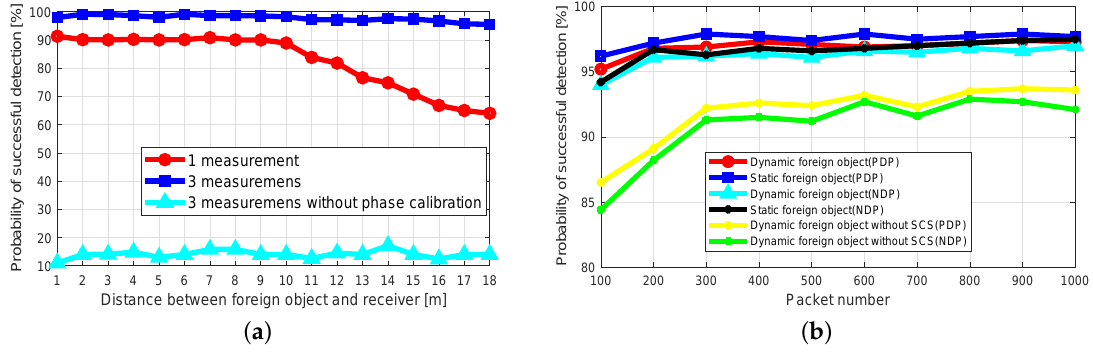
Figure 13. Experimental results of foreign object detection probability. ( a ) Impact of Distance to Receiver and the number of measurements on Detection Probability. ( b ) Impact of Packet Number on Detection